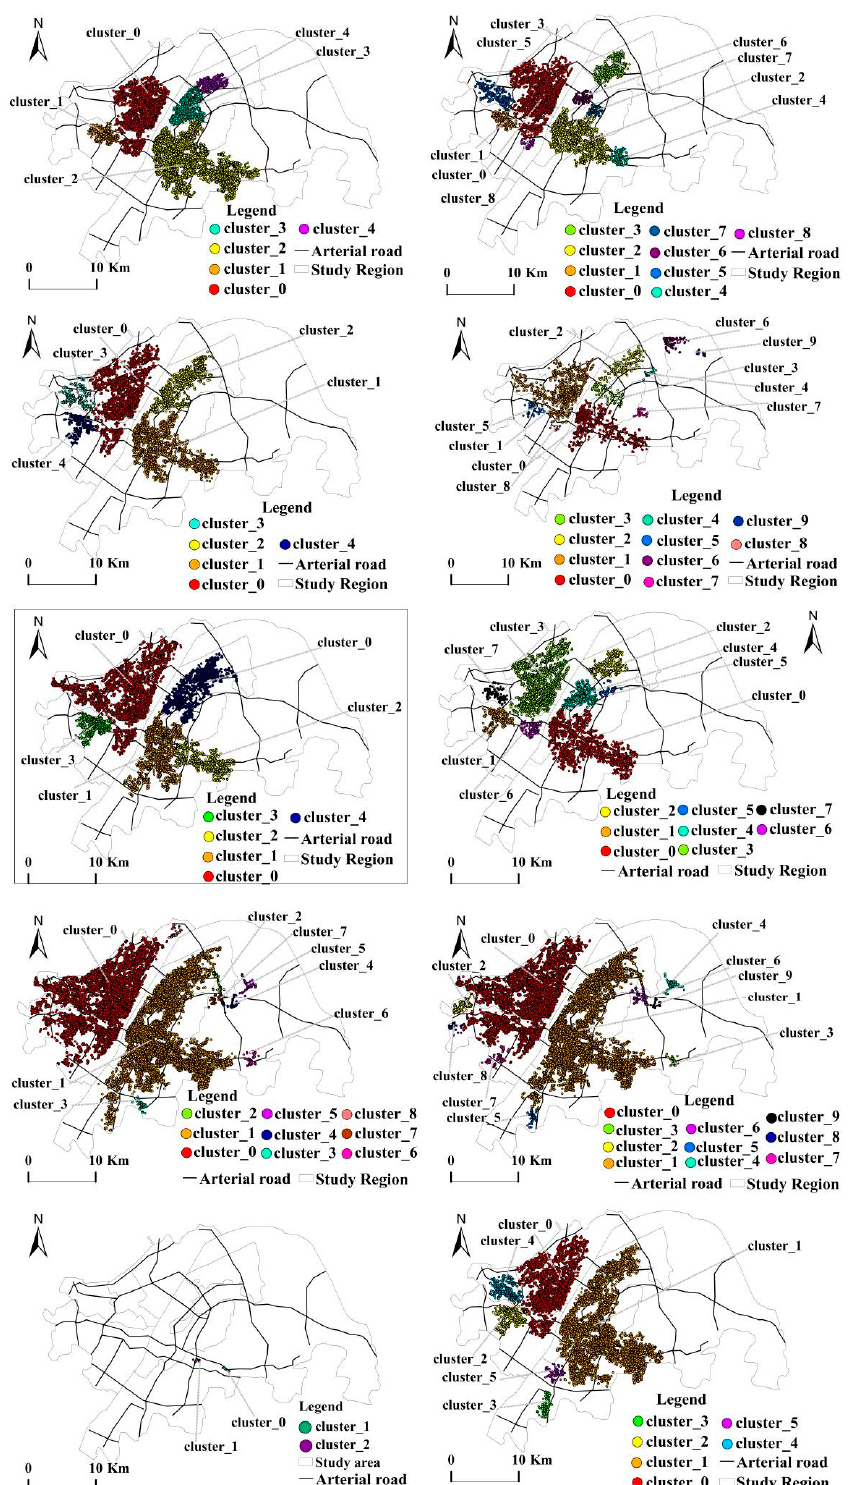
Figure 5. Spatial clustering distribution of the living elements. There are, however, certain dislocations or imbalances. The two important spatial nodes for medical care elements are both distributed in the Jianghan and Hanyang Districts on the north bank of the Yangtze River, and there is the phenomenon of uneven devel- opment. The two important spatial nodes for sports and leisure elements are distributed in the Wangjiawan living area and near the Hongmiao overpass, which is far from